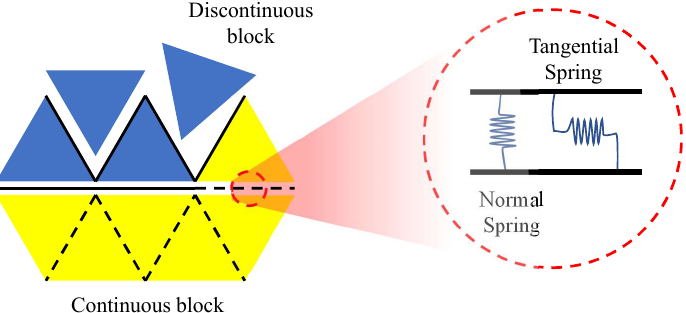
Figure 1. Constitutive model in the